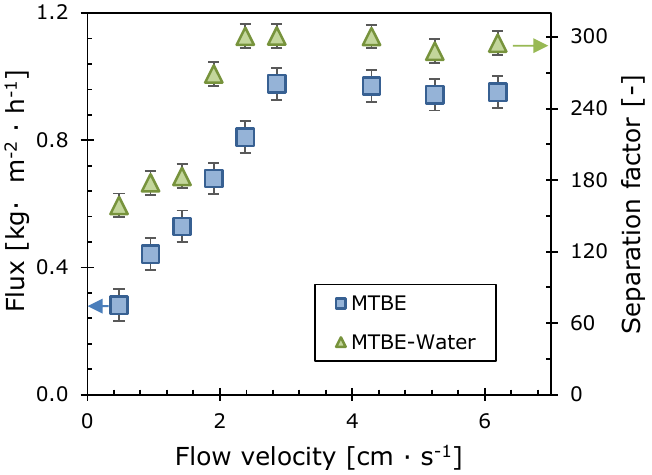
Figure 7. The dependences of the MTBE flux and the MTBE / water separation factor on the feed linear velocity. T = 50 °C, 1% wt. MTBE in water, composite membrane M10/MFFK.